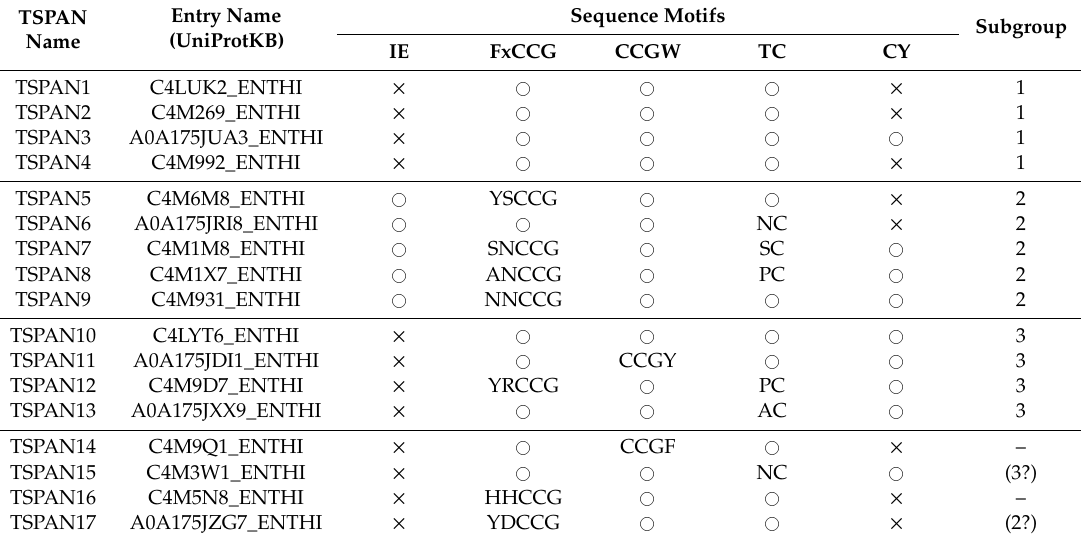
Table 2. Subgroups and motifs of 17 tetraspanins in E. histolytica .